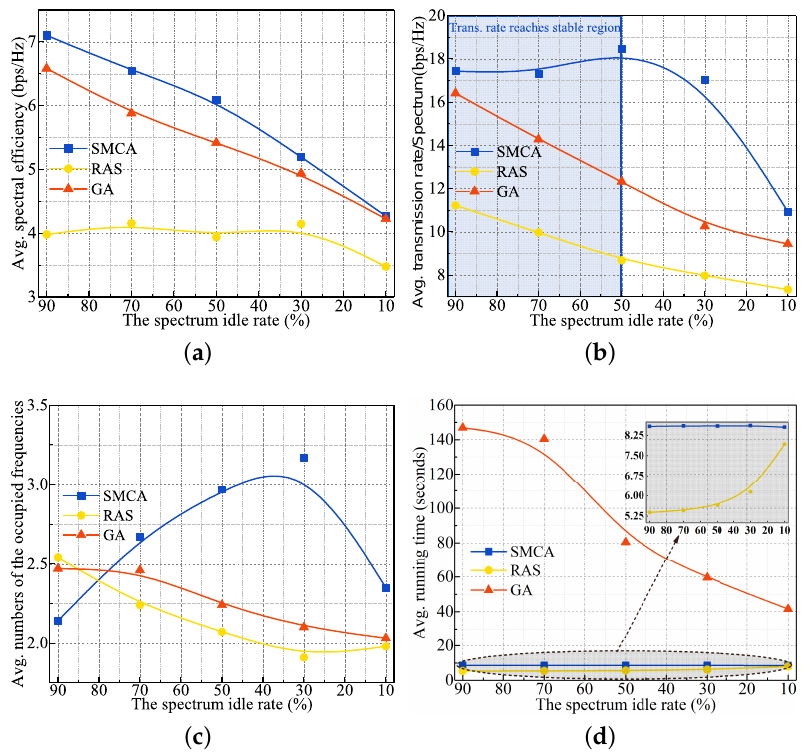
Figure 5. Performance results of the involved algorithms under different spectrum idle rates multi-hop scenario. ( a ) spectrum efficiency ( b ) multi-hop transmission rate ( c ) number of spectra occupied ( d ) execution